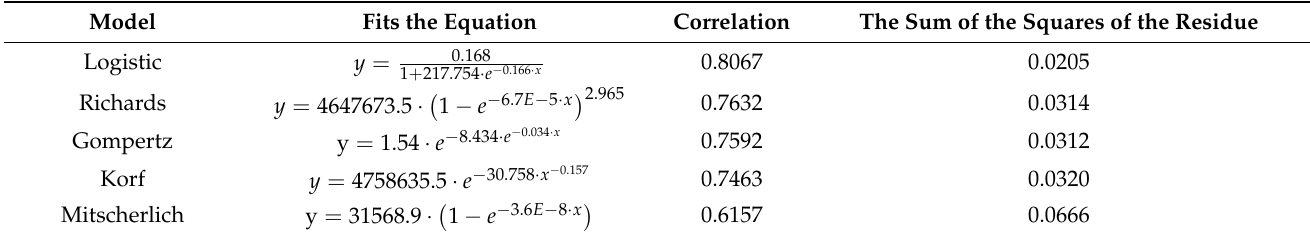
Table 3. Model fitting results.